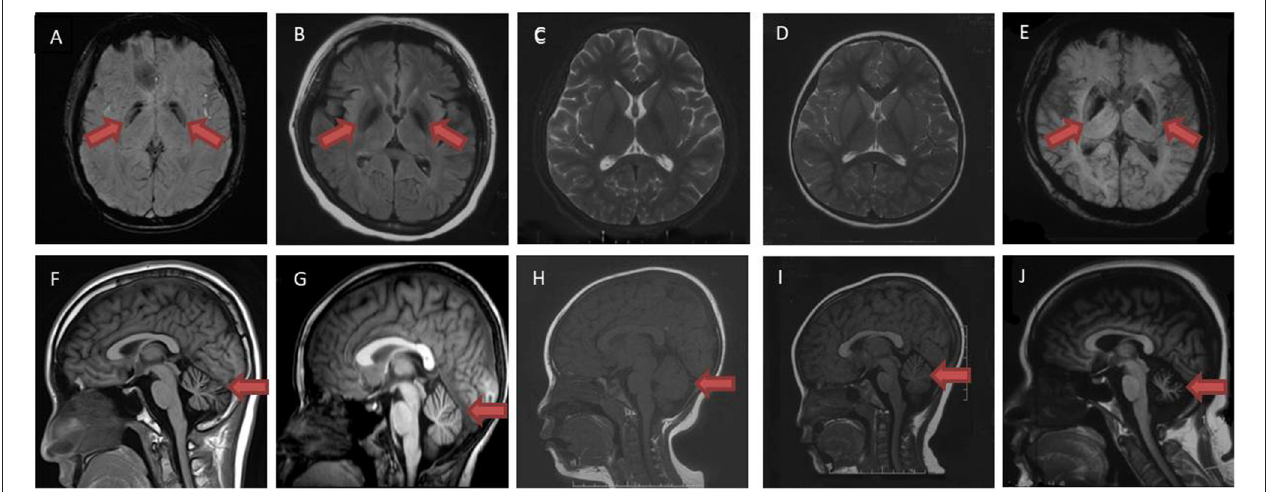
FIGURE 1 | Brain magnetic resonance imaging examination of patient A II-1 (A,F) , A II-2 (B,G) , B-II 1 (C,H) , B-II 2 (D,I) and C-II 1 (E,J) . Susceptibility weighted imaging sequences (A,E) and T2 flair sequences (B) demonstrated iron deposition in bilateral globus pallidus (red arrow). No iron deposition was shown in T2 sequence (C,D) in patient B-II 1, B-II 2. T1 sequences demonstrated cerebellar atrophy in patient A II-1, A II-2, B-II 1, B-II 2, C-II 1 (F–J) (red